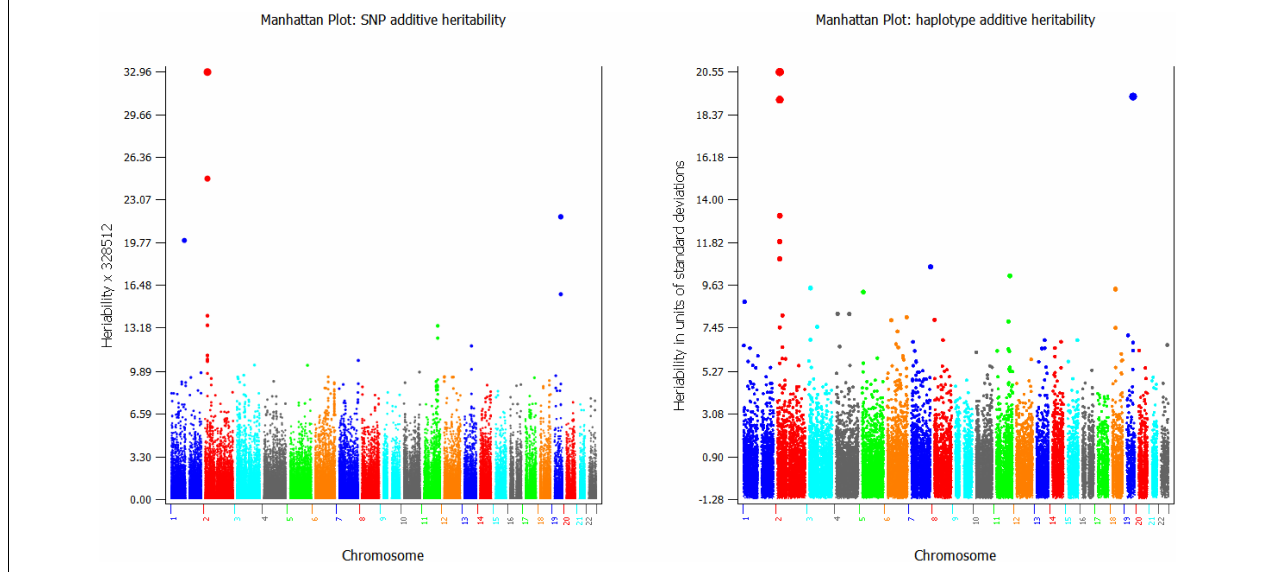
FIGURE 4 | Examples of graphical visualization of SNP heritabilities (left) and haplotype heritabilities (right). TABLE 2 | Computing time of GVCHAP using the Mesabi supercomputer. GVCHAP using one node with 62 Gb memory Multi-node processing